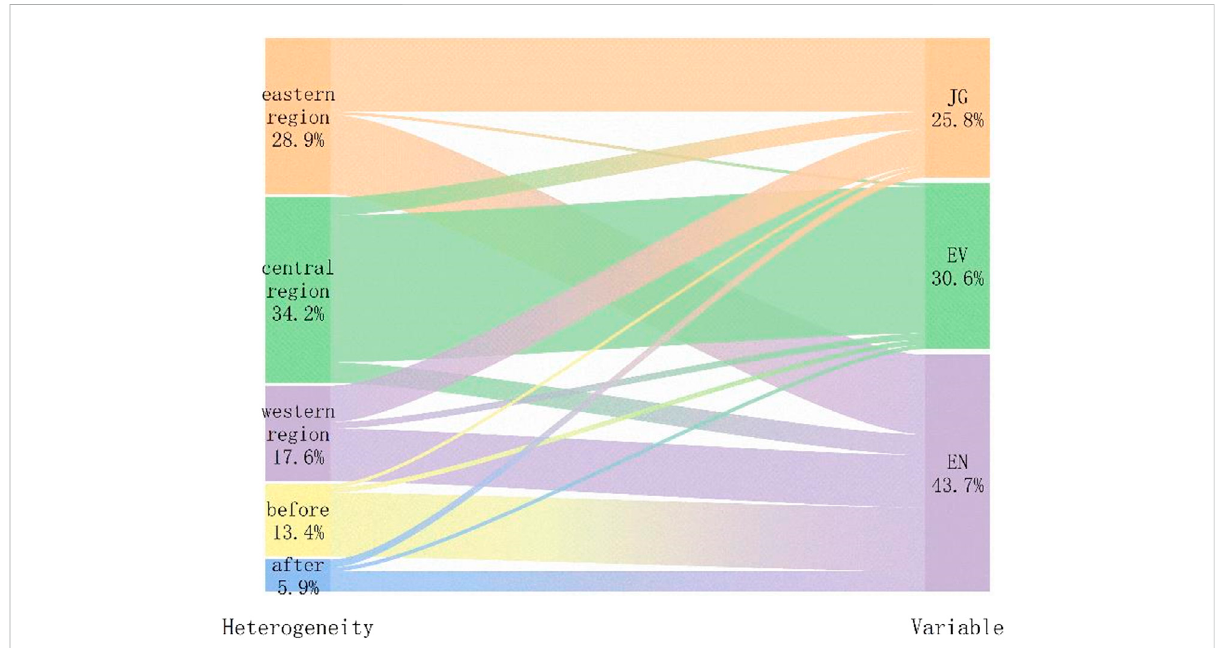
FIGURE 8 Impact of green fi nance on the spatial and temporal heterogeneity of high-quality economic development, environmental pollution, and energy consumption, and the impact on different regions of China and the impact of green fi nance before and after its proposition. Considering the differences in the economic level and resource allocation among eastern, central, and western regions of China, as well as the differences between different provinces and cities in the descriptive statistical results, the sample size is divided into three groups: the eastern, central, and western regions for regression again. The regression results show that the impact of green fi nance on the economy, environment, and energy is heterogeneousintheeastern,central,andwesternregions(seeSupplementaryTableS6fordetailedresults).Green fi nancewasclearlyproposedfor the fi rst time in 2015. Therefore, the sample size was divided into two stages, 2008 – 2014 and 2015 – 2018, for research (see Supplementary Table S7 for detailed results).